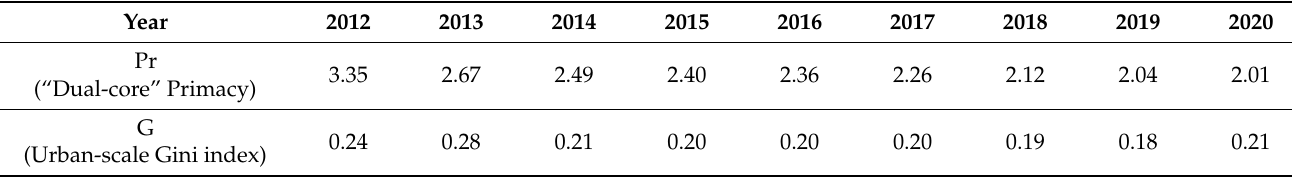
Figure 9. Total nighttime light value in Hangzhou from 2012 to 2020. Table 2. “Dual-core” primacy and urban-scale Gini index results obtained for the total nighttime light values in Zhejiang Province from 2012 to